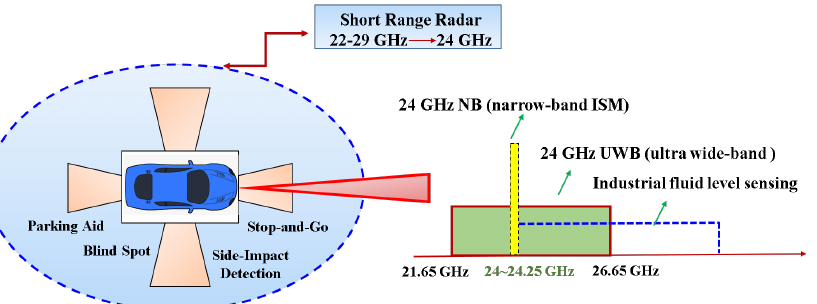
Figure 2. Automobile SRRS applications operate in the 22–29